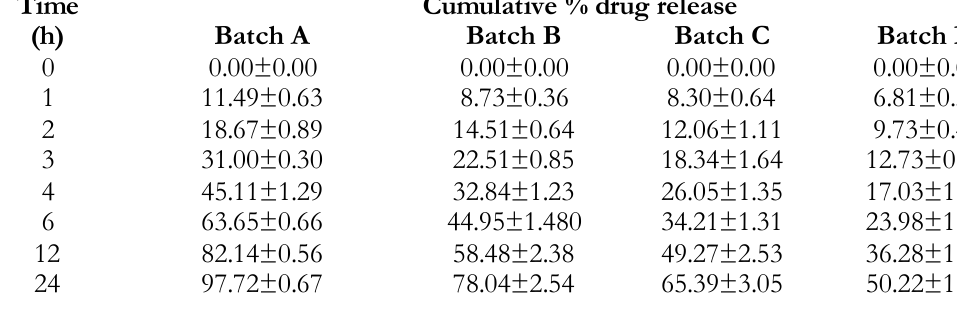
Table V. Data for determination of kinetics of drug release of timolol maleate ocular inserts Model